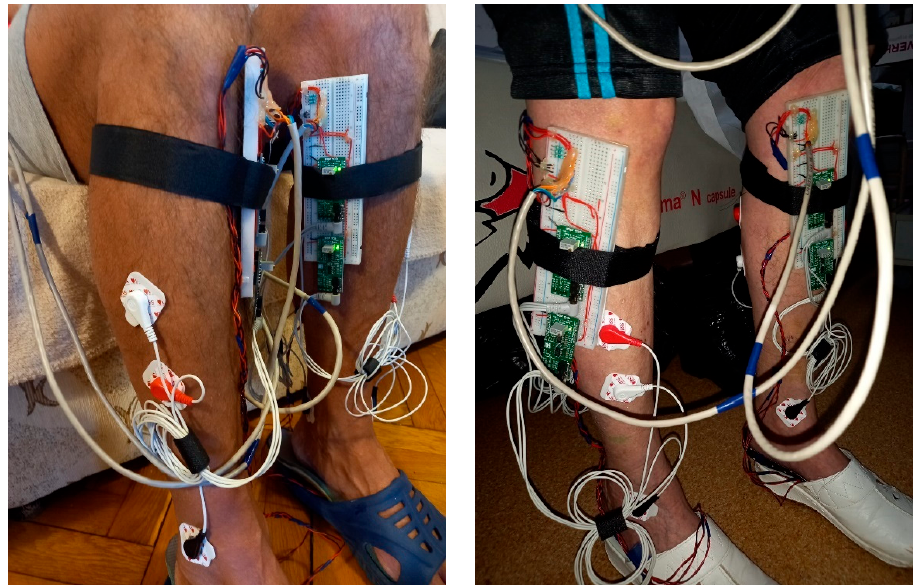
Gastrocnemius medialis (GM) muscles. Off-the-shelf MikroElektronika EMG Click boards